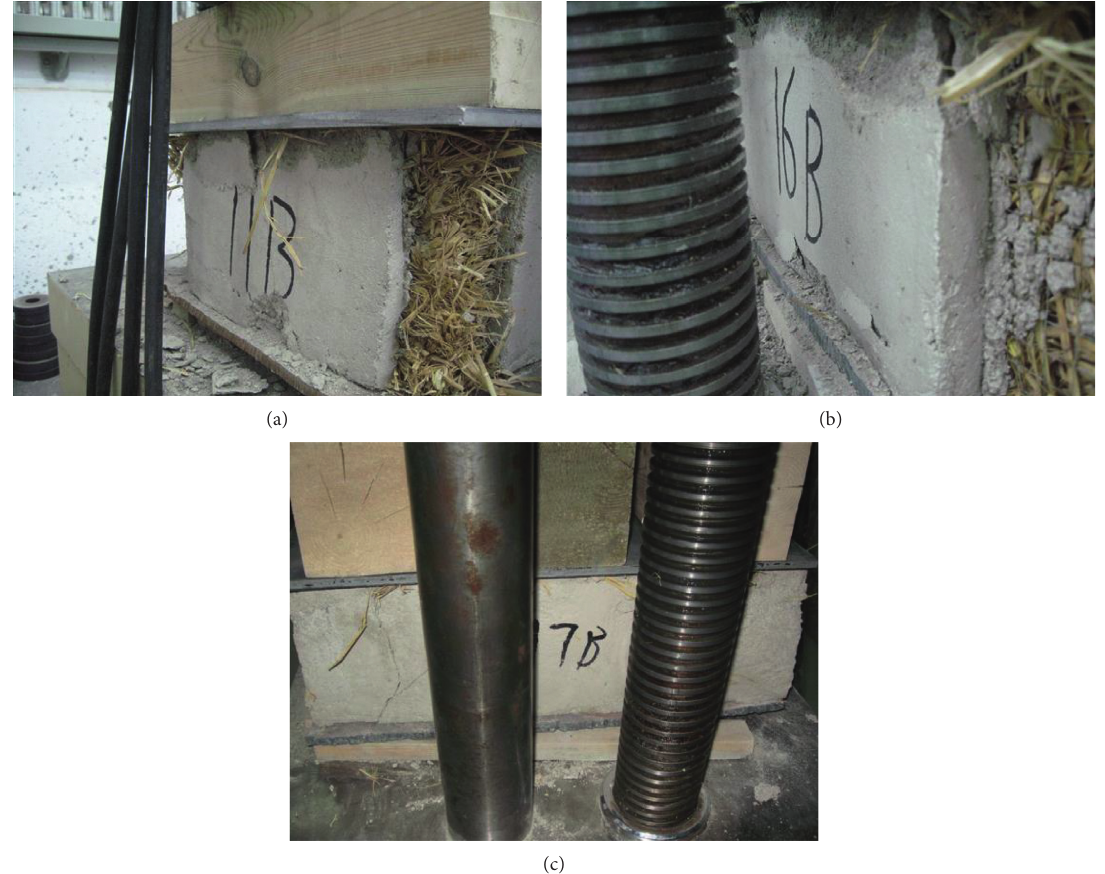
Figure 8: The phenomena of plastered straw bales. (a) Incompletely plastered straw bale. (b) Incompletely plastered straw bale with mesh. (c) Completely plastered straw